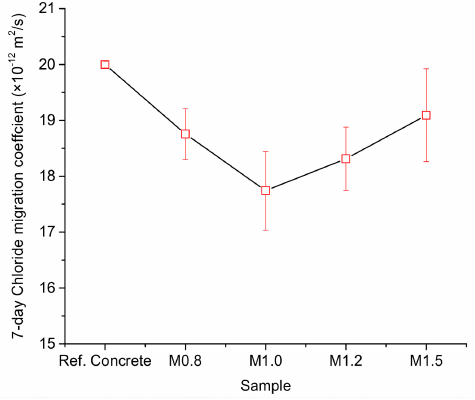
Figure 13. Chloride resistance of concrete sample sealed with the geopolymer